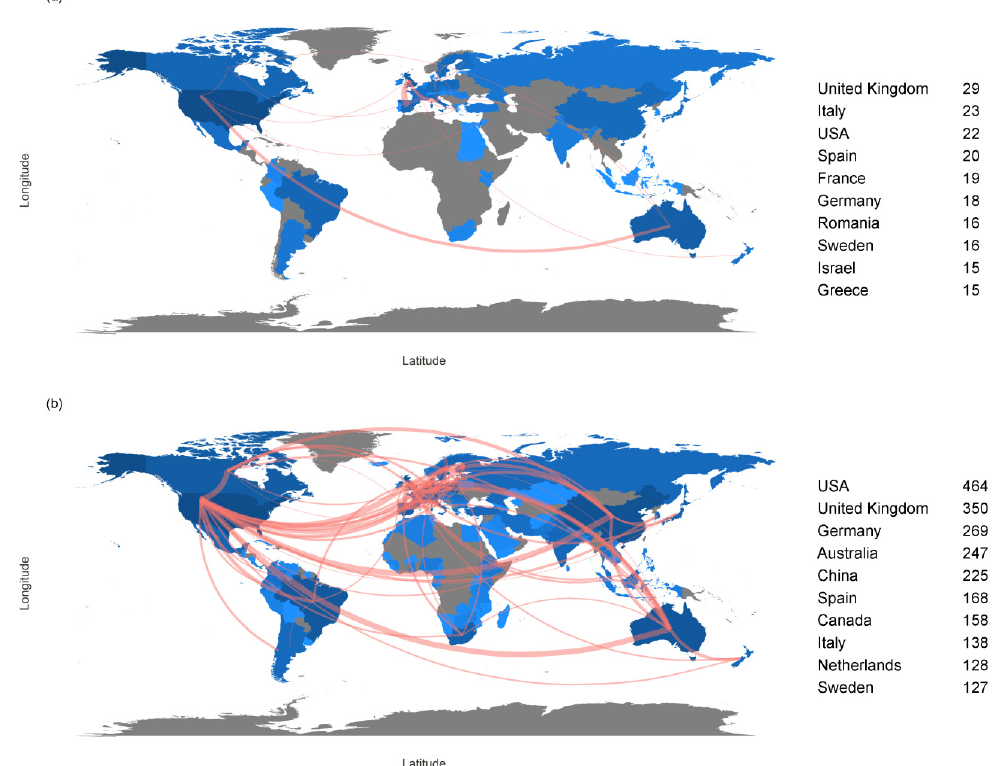
Figure 3. Country collaboration map. The red lines represent the cooperation and exchanges between the authors of the two countries. The more lines, the closer the exchanges. The numbers on the right represent the times a country exchanged scientific products with other countries. ( a ) 1998 to 2008. ( b ) 2009 to 2021.